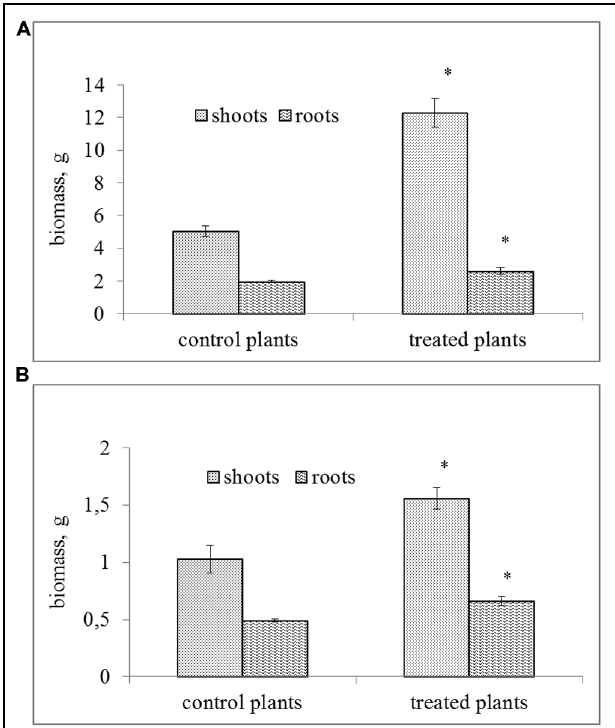
FIGURE 2 | The fresh (A) and dry (B) biomass of the shoots and roots of Sinapis alba L. growing in soil inoculated with the MH8a strain (mean ± SD, n = 3). ∗ Indicates singnificant differences at the 0.01 probability level.